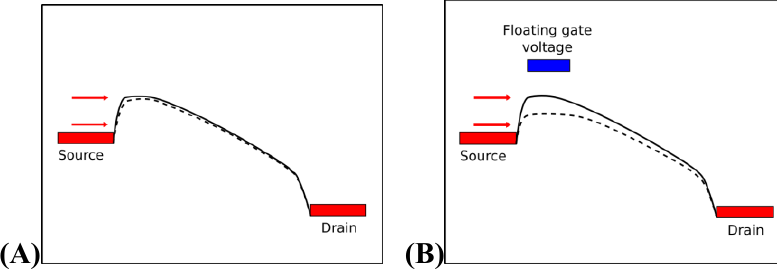
Fig. 2. Band diagrams of the structures. Weak variable injection effect in a diode structure (A) and strong effect in a transistor-like structure (B). The floating gate voltage controls the potential barrier height, hence, the current through the channel. In the case, the gate is connected with an antenna as well as the